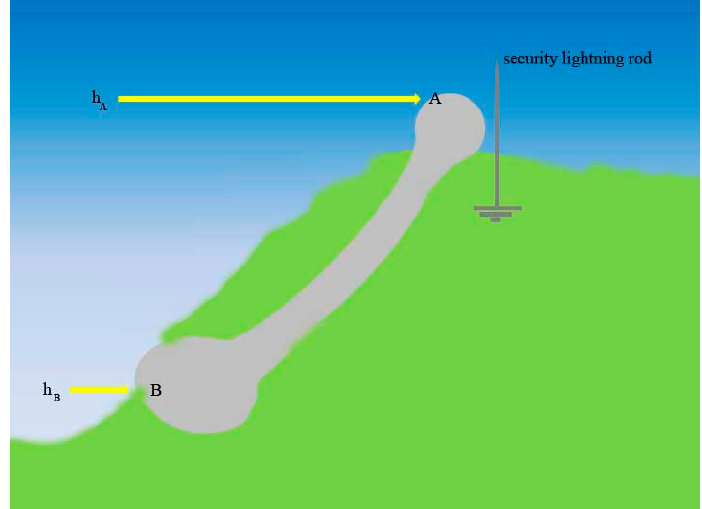
Figure 12. “ Bone ” device. A huge conductor is posed on the slopes of a hill or of a mountain or of a manmade building of suitable size. The shape reminds us about some kind of huge deformed “bone” of the cartoon-dog Pluto. The atmospheric potential gradient E originates, by electrostatic induction, a potential difference V AB = (h A − h B ) × E (absolute value) between A and B. The maximum useful power depends on the unknown amount of power supplied by the natural atmospheric circuit. See